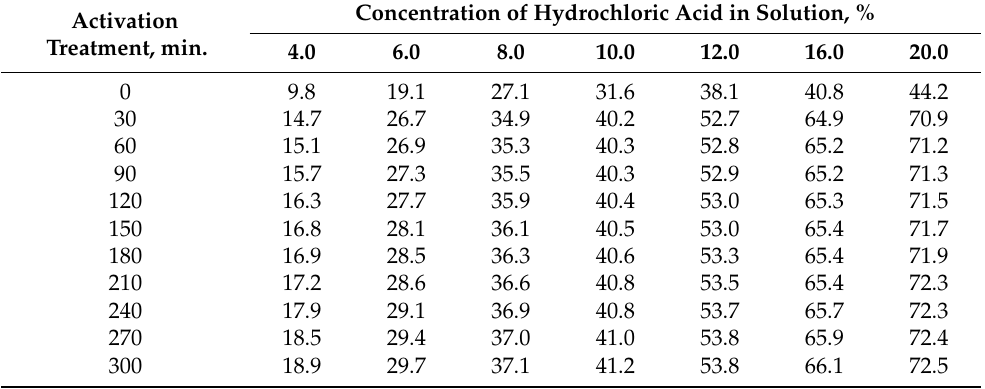
Table 2. Extraction of iron from tailings. Activation Treatment,